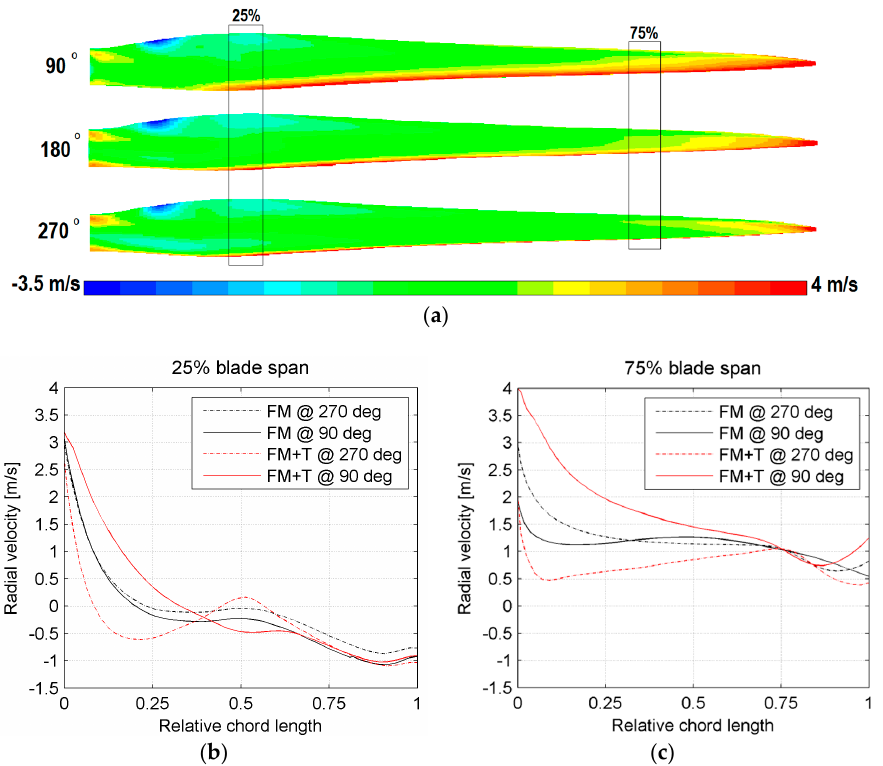
Figure 13. ( a ) Contours of the radial velocity in the first computational cell attached to the blade wall over the pressure side of the blade at a 90 ◦ , 180 ◦ , and 270 ◦ azimuth angle in the FM + T configuration (see Figure 4 for the sign convention) and a comparison of the same velocity at ( b ) 25% and ( c ) 75% of the blade in the FM + T and FM configuration.